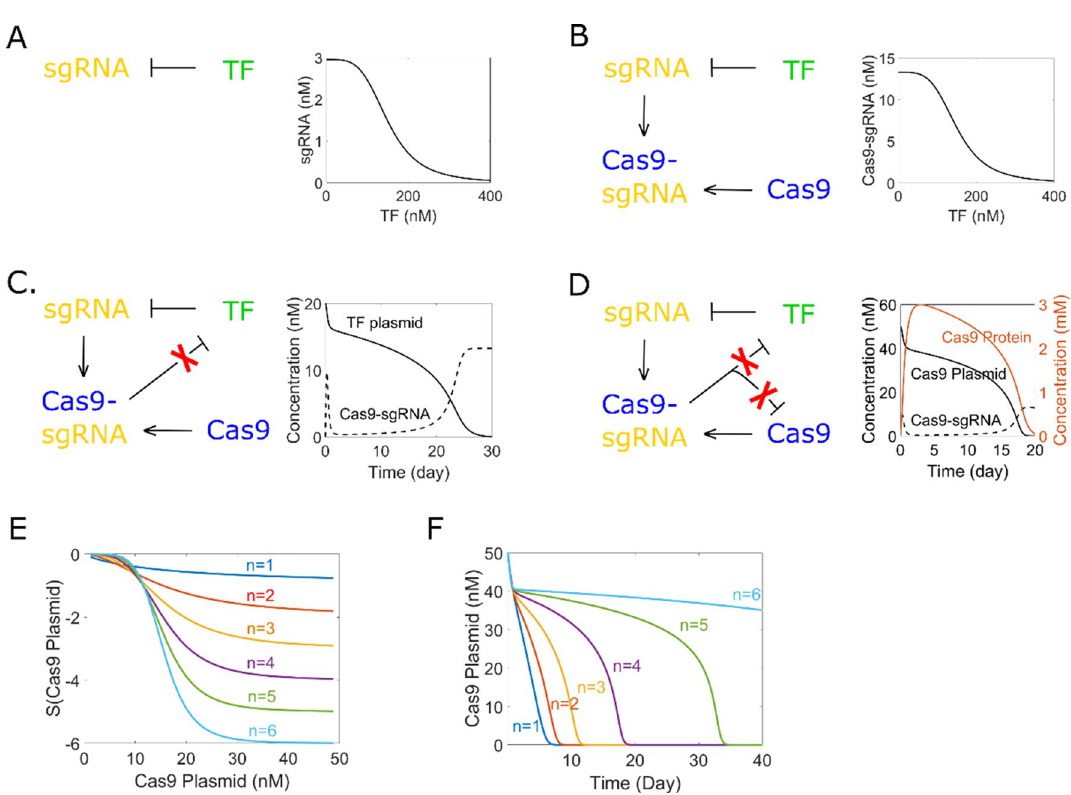
Figure 2. Ultrasensitivity transmission and time delay. TF stands for transcription factor. ( A ) Cooperativity of transcription factor binding the target site generates the ultrasensitivity. sgRNA concentration (output) is highly sensitive to TF concentration (input) around a threshold. ( B ) Ultrasensitive relationship between Cas9- sgRNA and TF. ( C ) Time delayed TF elimination. Ultrasensitive relationship is built between Cas9-sgRNA (enzyme) and TF (substrate). ( D ) Time-delayed Cas9 elimination. Ultrasensitive relationship is built between Cas9-sgRNA (enzyme) and Cas9 plasmid (substrate). Response of Cas9 protein has a short delay compared to Cas9 plasmid. Cas9 protein maintains a certain value before rapid elimination. ( E ) Response of Cas9-sgRNA concentration (output) to Cas9 plasmid concentration (stimulus) is more sensitive with higher Hill coefficient n (n = 1, 2, 3, 4, 5, 6). ( F ) Higher value of Hill coefficient n leads to longer delay time and larger difference in Cas9 elimination